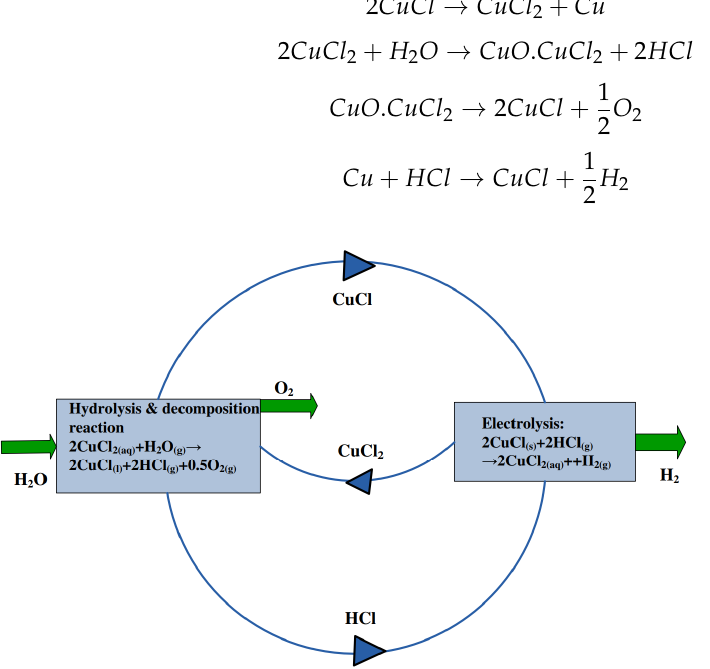
Figure 8. A sample two-step Cu-Cl cycle for hydrogen production (Reproduced with permission from [167], Wiley;